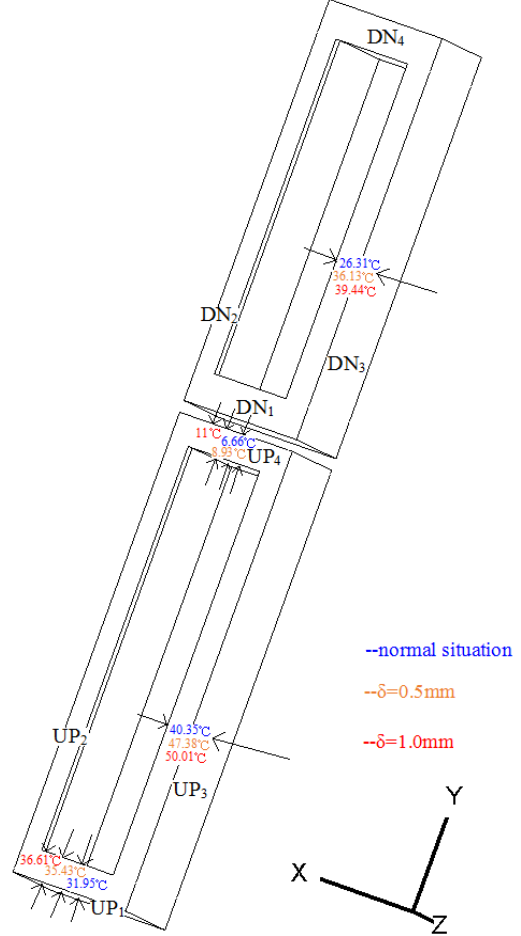
Figure 3. The position definition of stator main insulation and the maximum temperature drop in three cases.